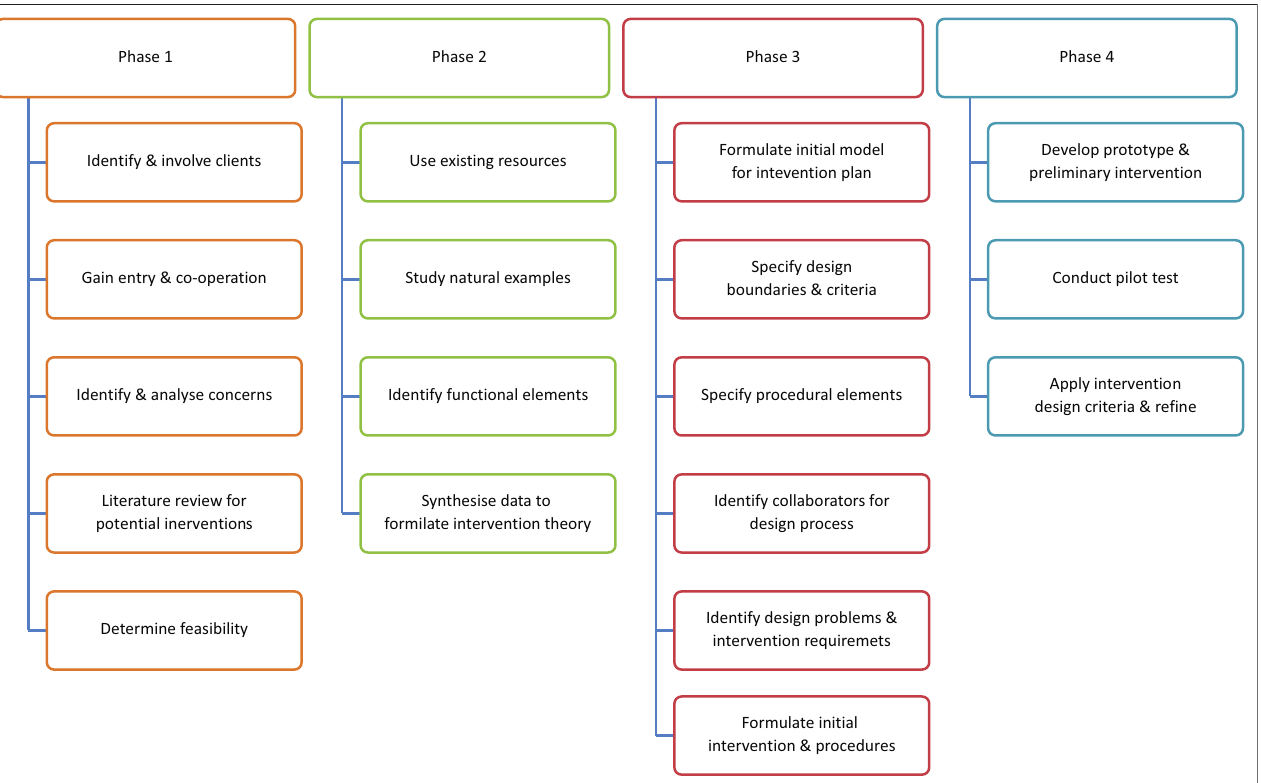
FIGURE 1: Executed operational steps of the design and development